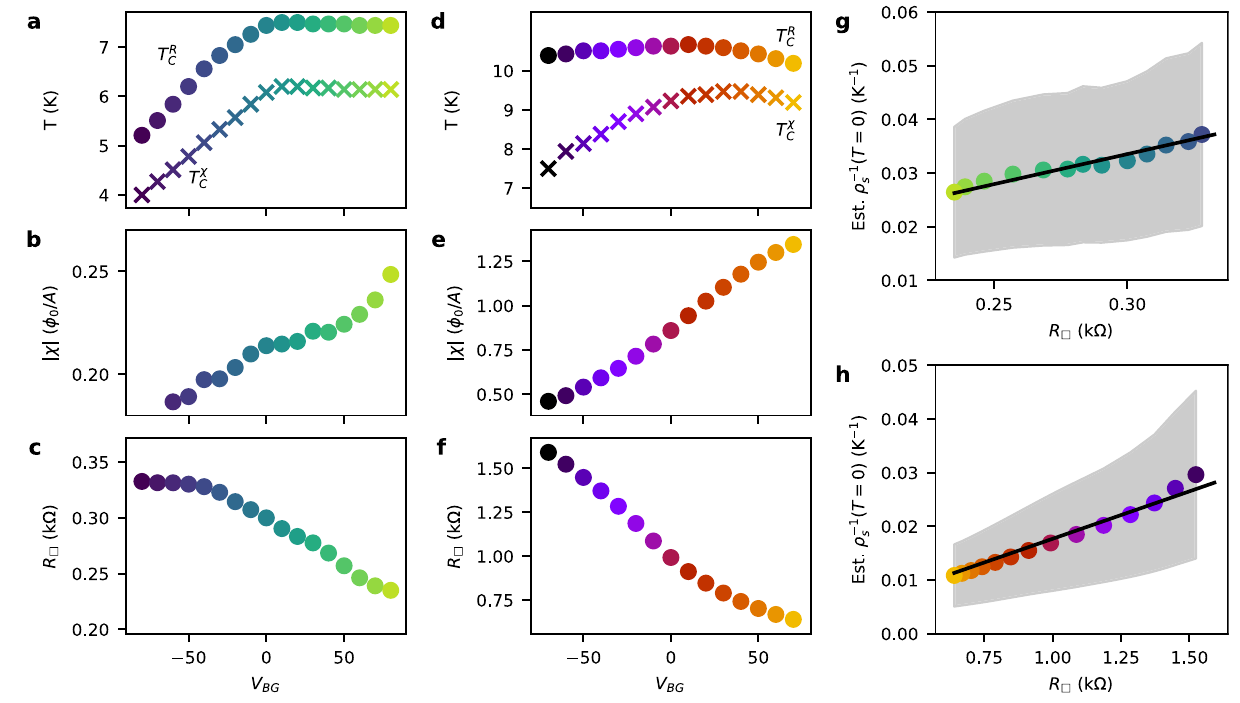
Fig. 3 | Correlation between device resistivity and super fl uid stiffness. a – c Summary of properties of the superconducting state in device A versus V BG . a Two measures of the critical temperature: T R c at which the resistance has decreased by 10% from the normal value and T χ c at which the super fl uid response startstoexceedournoise fl oor. b χ extractedat T =0 : 9 T χ c . c R □ at8K. d – f Sameas a – c butfordeviceB. e χ isshownat T =0 : 55 T χ c ,for f R □ isshownat12K. g Inverseof